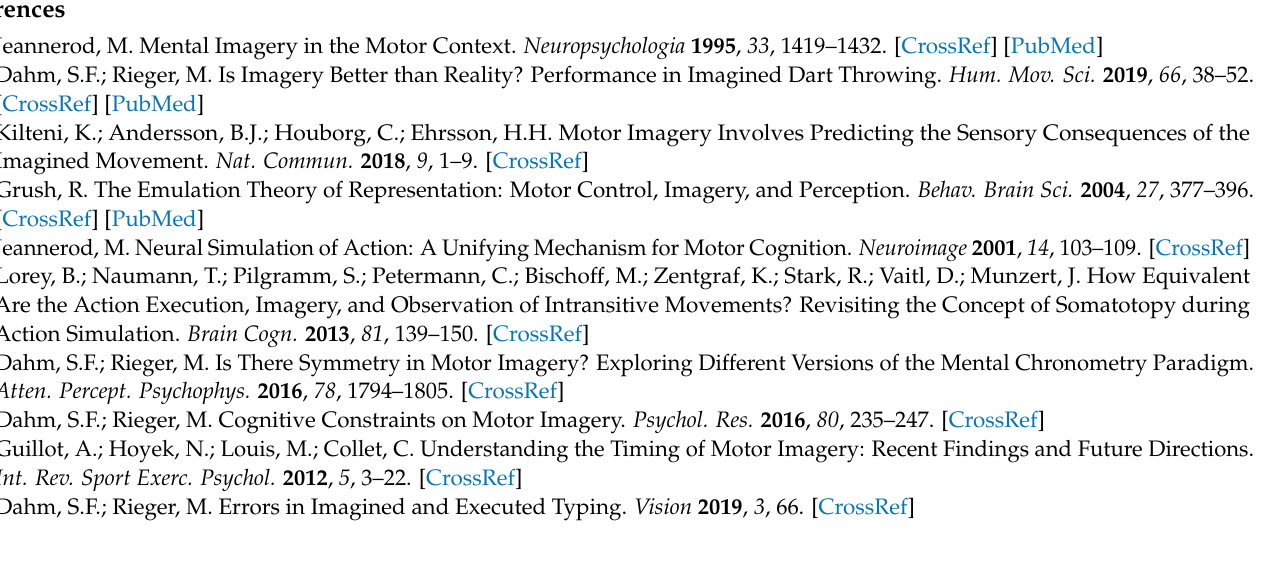
female and male participants; Table S1: Statistical results of the ANOVA on reaction times: Table S2: Statistical results of the ANOVA on error